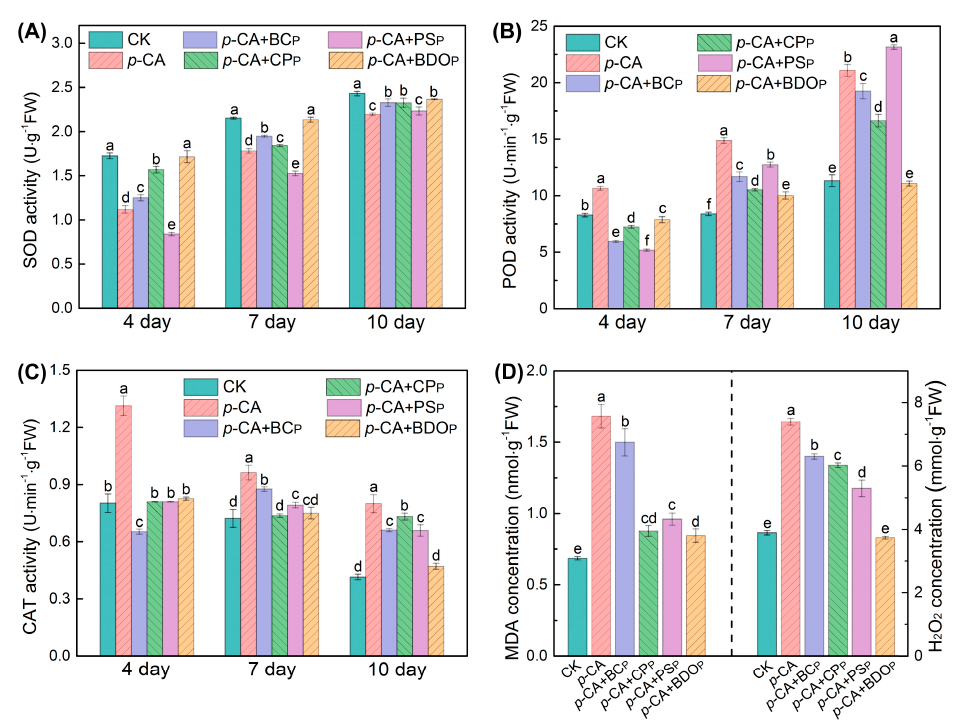
Figure 3. Effects of various treatments on the enzymatic activities of superoxide dismutase (SOD) ( A ), peroxidase (POD) ( B ), and catalase (CAT) ( C ) in tomato seed radicals. The contents of malondialdehyde (MDA) and H 2 O 2 were measured in tomato seed radicals on the 7th day of culture ( D ). Treatment abbreviations: CK, control check with ddH 2 O; p -CA, stress treatment with 10 mL 400 mg/L p -coumaric acid; p -CA + BC P , p -coumaric acid with biochar particles; p -CA + CP P , p -coumaric acid with calcium peroxide particles; p -CA + PS P , p -coumaric acid with potassium persulfate particles; p -CA + BOD P , p -coumaric acid with biochar-dual oxidant particles. Bars represent mean ± SD ( n = 4). Different letters indicate significant statistical differences between treatments (One-way ANOVA, LSD test, p <